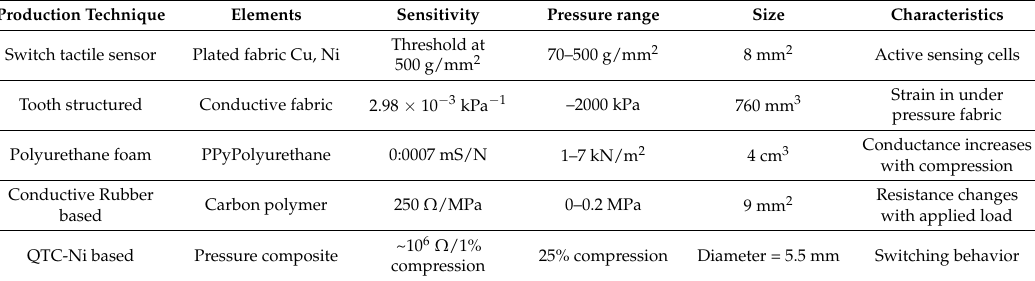
Table 4. Textile pressure sensors based on resistive mechanism